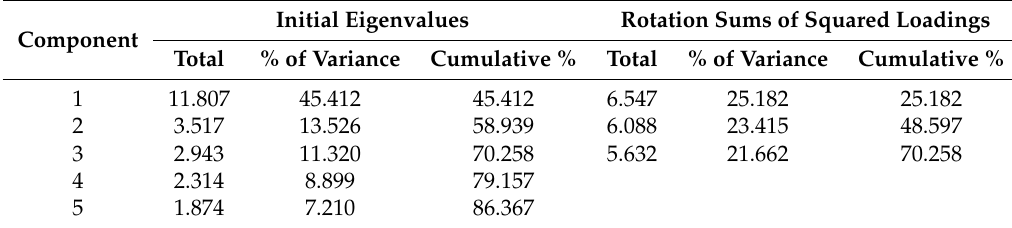
Table 5. Output factors—total variance explained (Source: own calculation and elaboration).